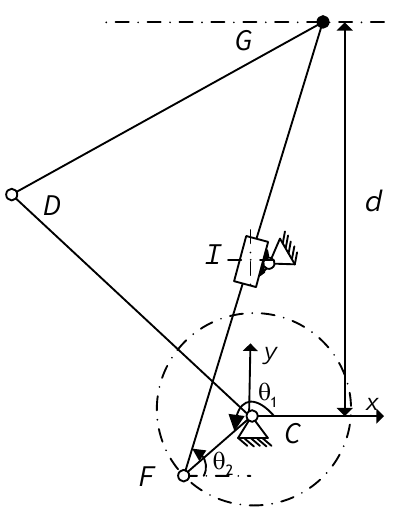
Figure 5. Kinematic model of the VGS finger mechanism.